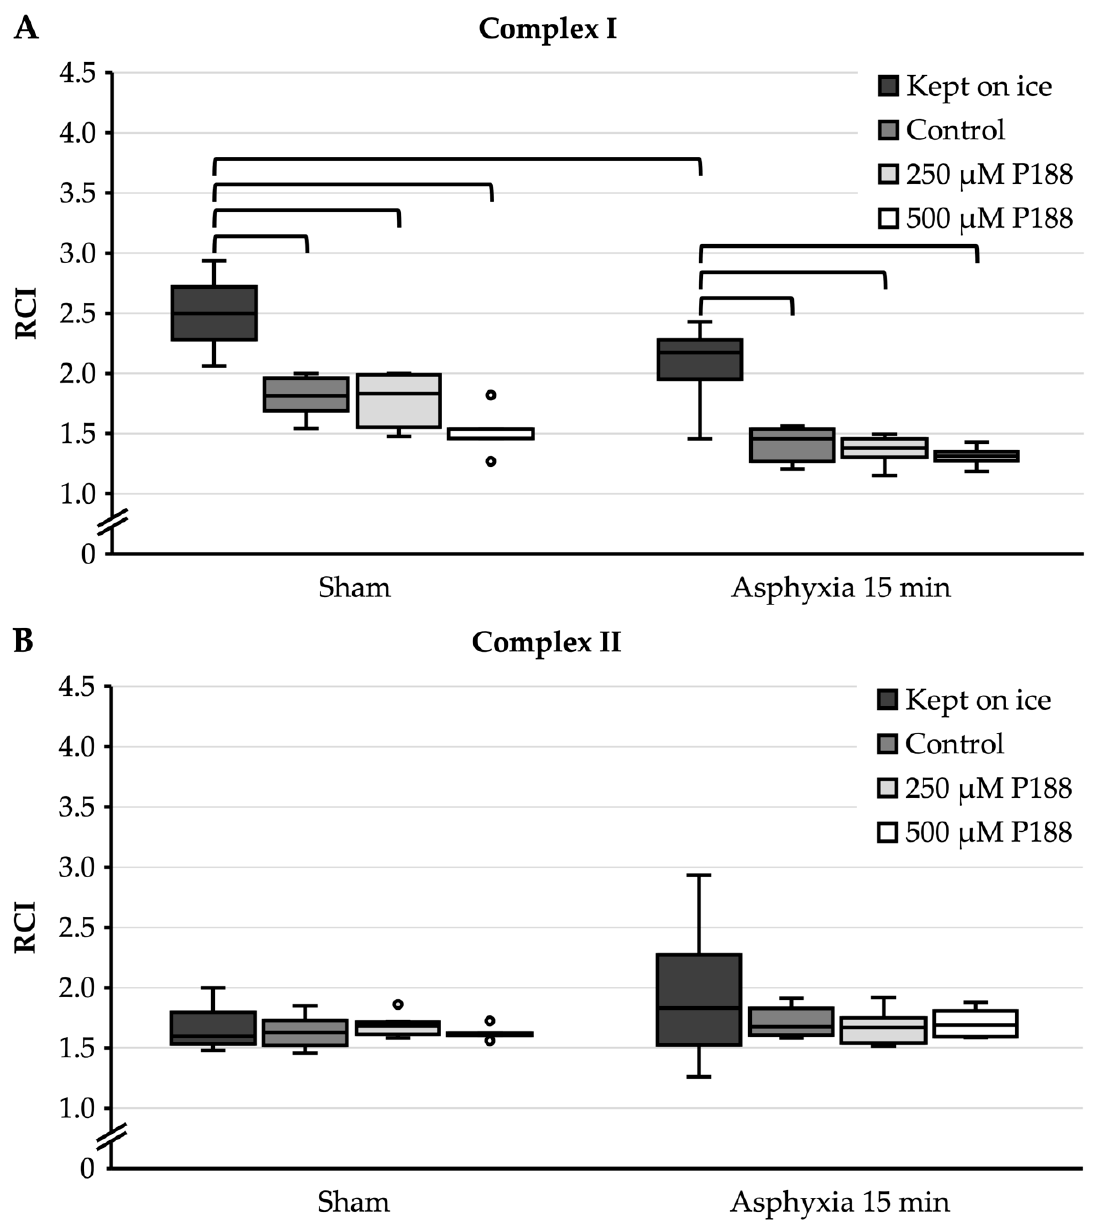
Figure 4. Comparison of respiratory control index (RCI) of oxygen (O 2 ) consumption in cardiac arrest (CA)-injured, isolated mitochondria for complex I ( A ) and II ( B ) substrates in mitochondria continuously kept on ice, control, treated with 250 µM Poloxamer (P)188, and treated with 500 µM P188. Prior to mitochondria isolation, asphyxial CA had been induced in the rats with an asphyxial time of 15 min. Sham rats were ventilated throughout anesthesia without induction of asphyxia. Boxplots show 25th, 50th, and 75th percentile; whiskers represent minimum and maximum. Statistical significance ( p < 0.05) denoted by brackets; complex I: n = 3; complex II: n = 3.